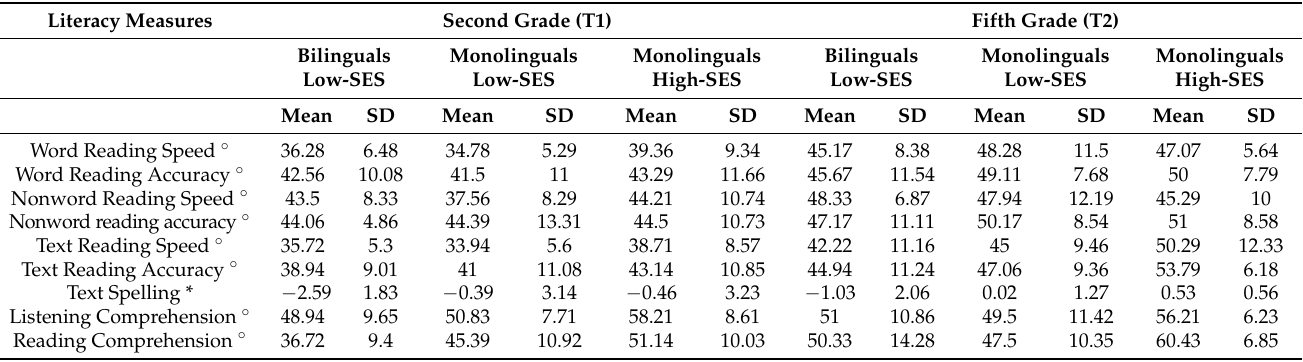
Table 2. Mean scores and sd for each literacy task in second and fifth grade for the three